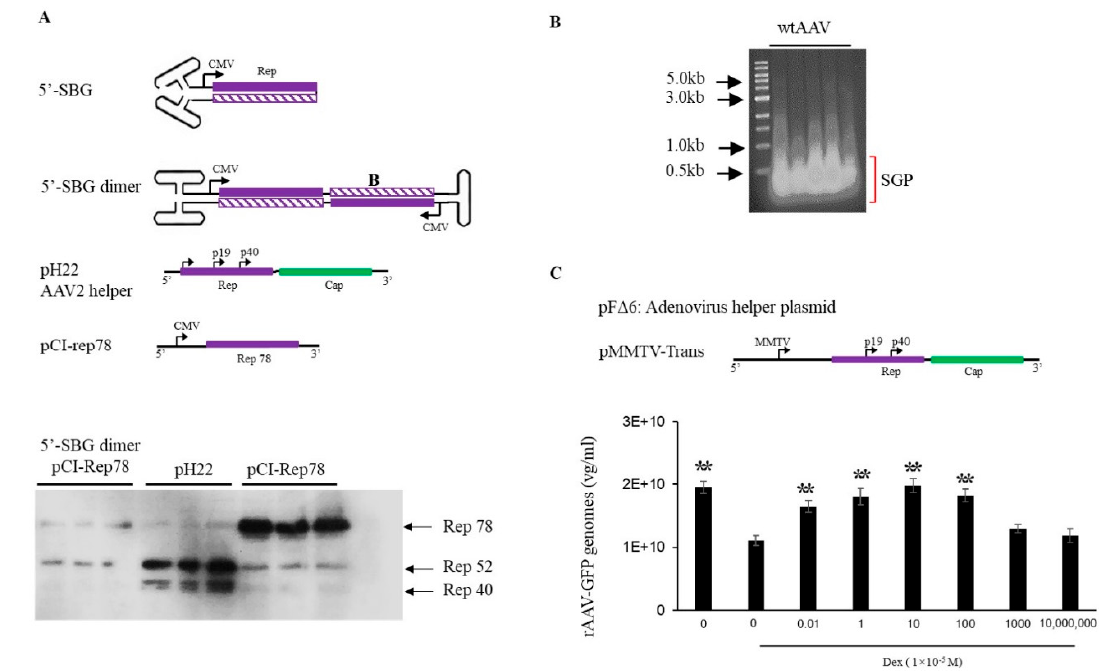
Figure 2. Effects of AAV 5 (cid:48) -SBG dimers on rep gene expression. ( A ). Top panel, sketch of a 5 (cid:48) -SBG in self-complementary configuration; 5 (cid:48) -SBG dimer is extended form of 5 (cid:48) -SBG after 2nd stranded DNA synthesis; pH22 is the AAV2 helper plasmid expressing low level of Rep78; pCI-Rep78 is the high Rep78 expression plasmid. Bottom panel, Hek 293 cells were transfected with pCI-Rep78 with or without the presence of 5 (cid:48) -SBG dimers. 5 (cid:48) -SBG dimers were made as detailed in the experiment methods. The transfected cells were harvested at 24 h post-transfection and the expression of proteins were electrophoresed in 10% PAGE gel. The rep proteins were detected by western blot using mouse anti-AAV-Rep 76.3 antibody. Shown in the Figure are triplicate of each testing condition. Effects of AAV subgenomic particles (SGP) on rAAV replication and packaging. ( B ). AAV SGP were separated in an agarose gel and less than 1 kb SGP DNA identified in an agarose gel, isolated for the transfection. ( C ). The adenovirus helper plasmid pF ∆ 6, pMMTV-trans and pssAAV-CB-GFP were co-transfected into 293 cells with or without SGP DNA. Rep expression was under the control of a MMTV promoter in pMMTV-trans, which is inducible by Dexamethasone. ssAAV-GFP was collected at 72 h post-transfection and measured by qPCR. The X axis showed the copy number of SGP molecules used for transfection. “0” means no SGP DNA was added. The cells treated with DEX (1 × 10 − 5 M) are indicated in the Figure. Y axis: rAAV-GFP yield expressed by vector genomes per ml. ** means p < 0.05, there is statistically significant as compared to 0 M Dex treatment